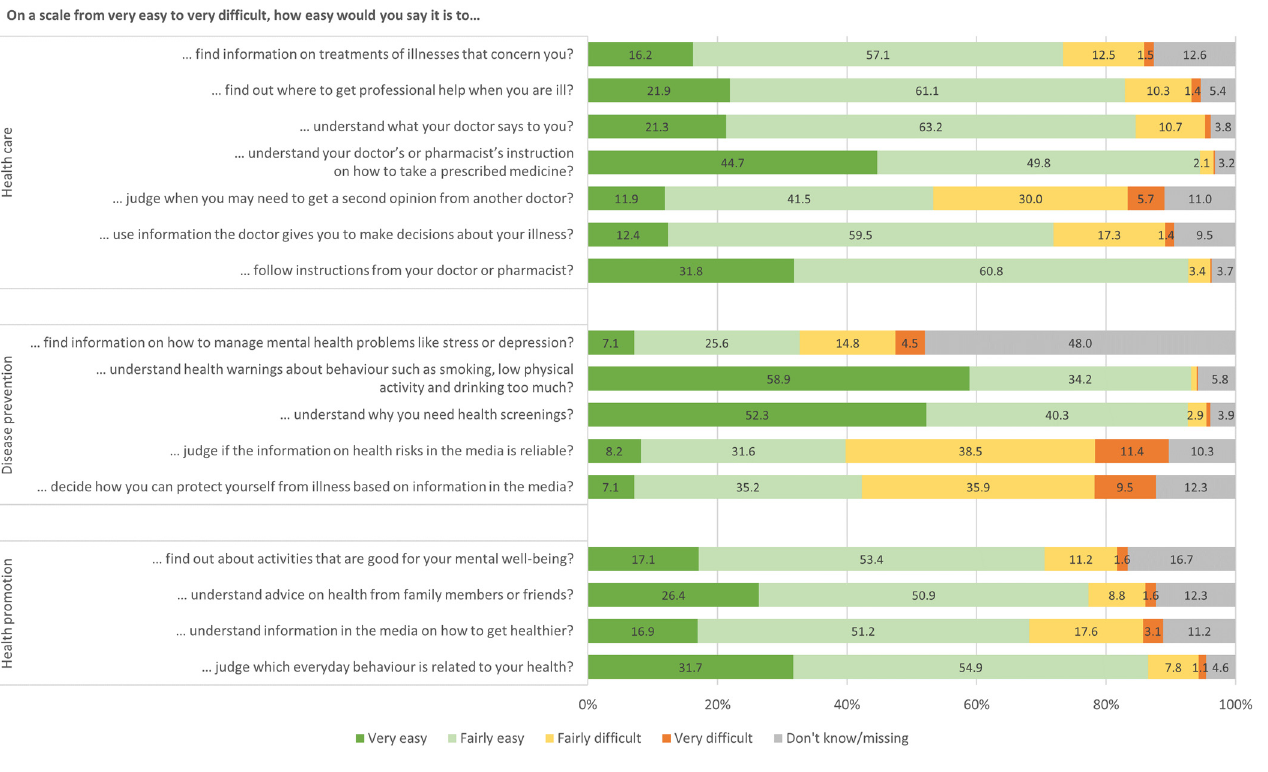
Figure 1. Percentage distribution of responses for the HLS-EU-Q16 items sorted by fields of health care, disease prevention and health promotion ( n = 3601). Note: values <1.0% are not shown.